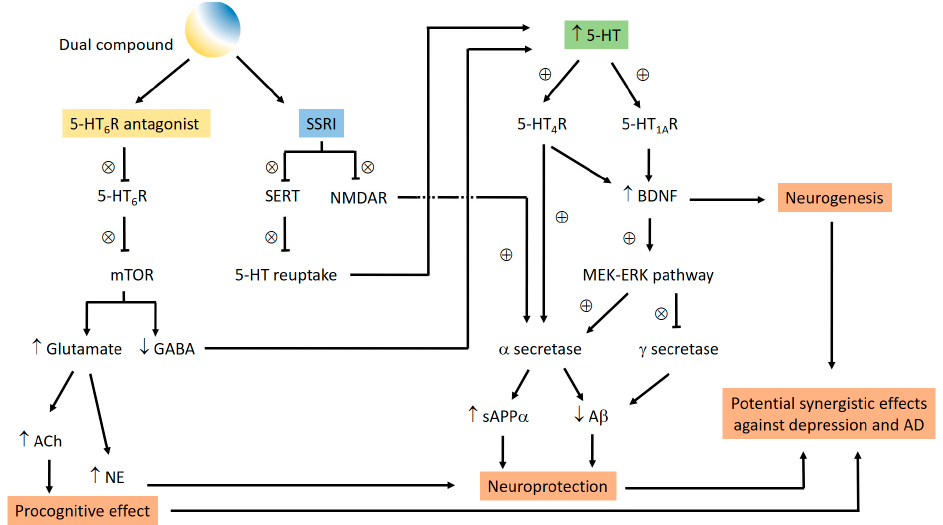
Figure 19. Hypothetical mechanisms of a dual SSRI/5-HT 6 R antagonist.